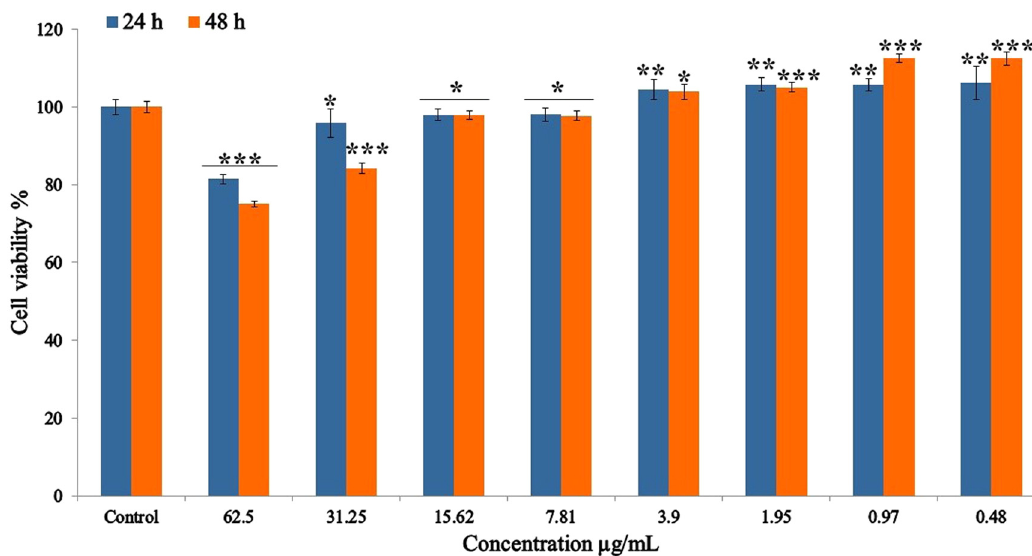
Figure 6: Cytotoxicity assessment of nanoemulsion on human mesenchymal stem cells after 24 and 48 h assessment. Data represent mean ± SD of triplicates, and the control was not treated with nanoemulsion; thus, viability was assumed to be 100%. The statistical signi fi cance at di ff erent levels * p < 0.05, ** p < 0.01, and *** p <